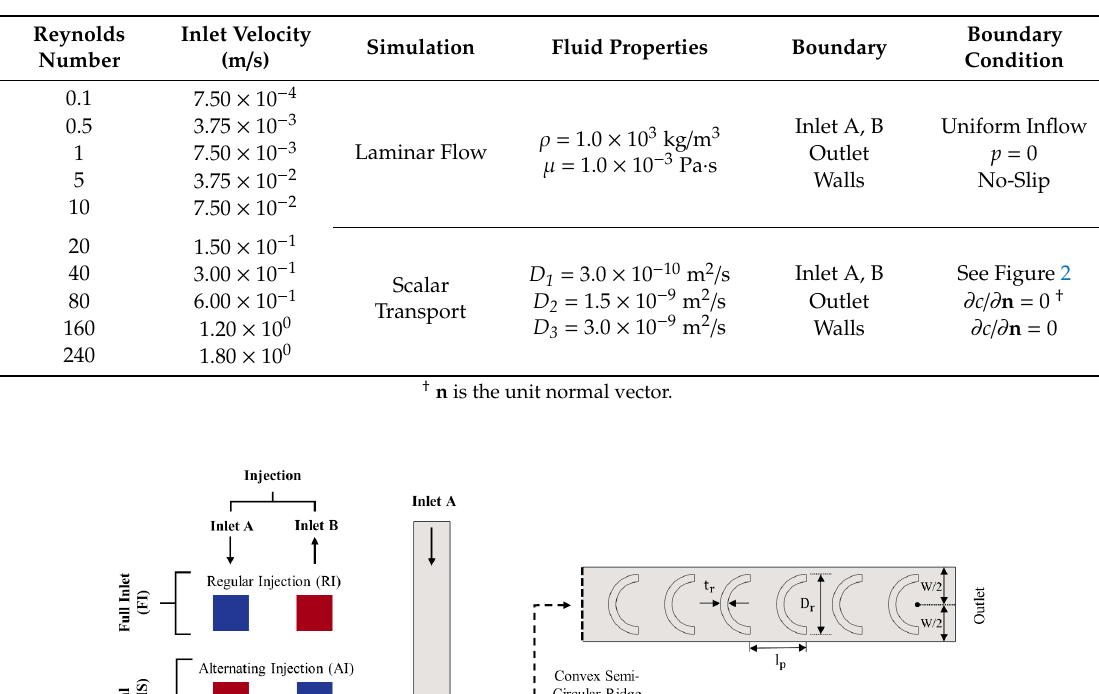
Table 1. Flow scenarios, physical fluid properties, and boundary conditions.